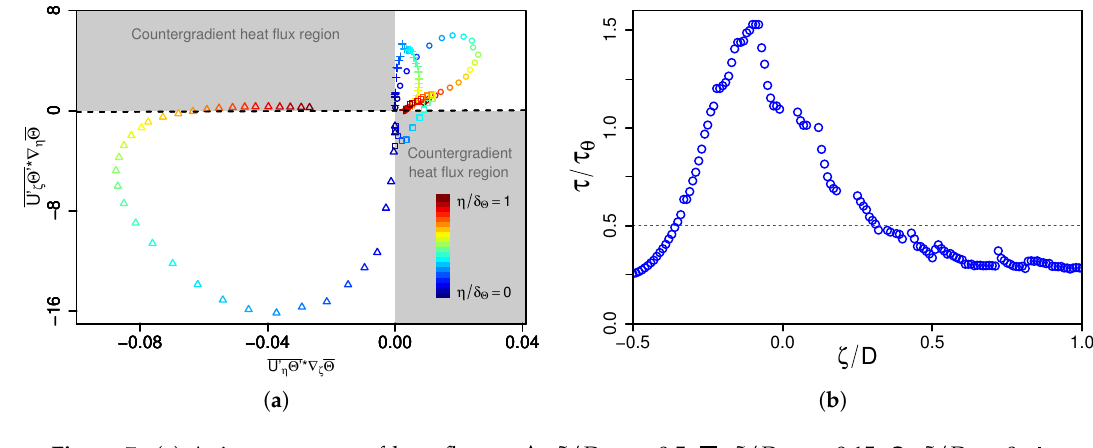
Figure 7. ( a ) Anisotropy map of heat fluxes. : ζ / D = − 0.5, : ζ / D = − 0.15, : ζ / D = 0, : ζ / D = 1. The dashed line represents the isotropic state where U (cid:48) ratio of mechanical ( τ = k / (cid:101) ) and thermal ( τ θ = T (cid:48) 2 / (cid:101) at a wall distance of η = 0.5 ∗ δ Θ